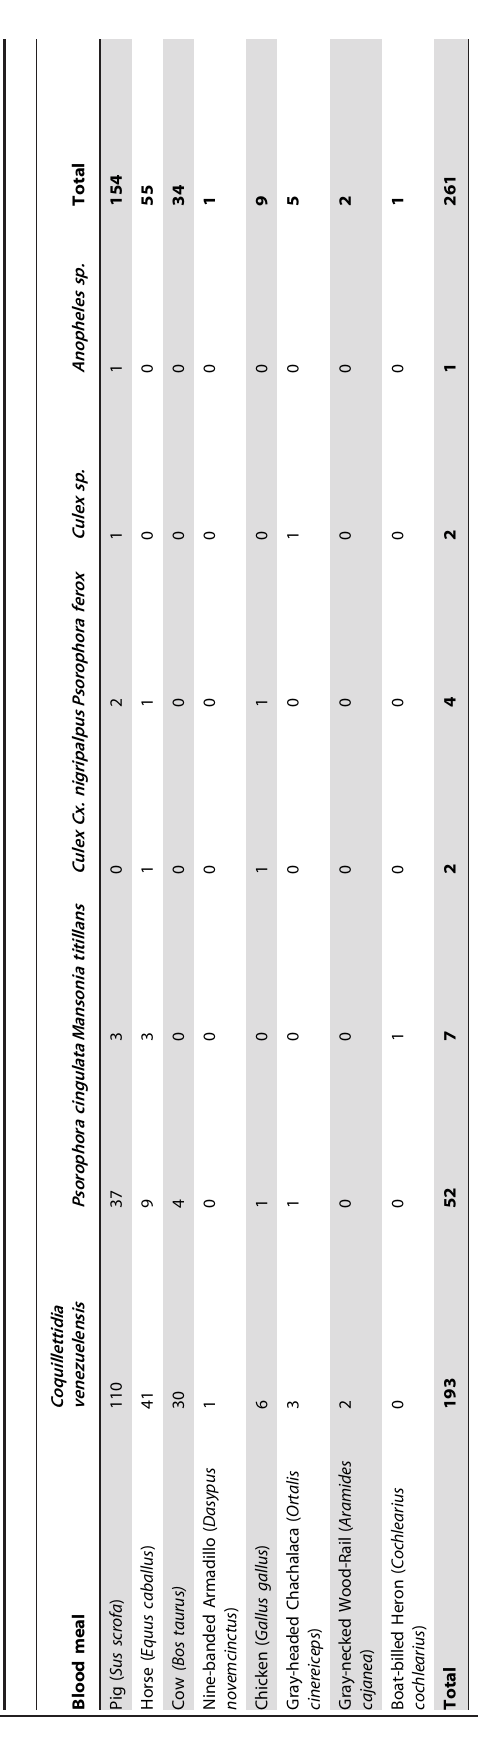
(Figure 3: least-squares linear regression: R 2 = 0.54; p =0.0008). Importantly, wild birds and mammals had low representation among our identified blood meals and low estimated biomass in the Aruza Abajo region while species of domestic animals (pigs, cows, and horses) had high estimated biomass and relative study. Other domestic animals had moderate and low biomass